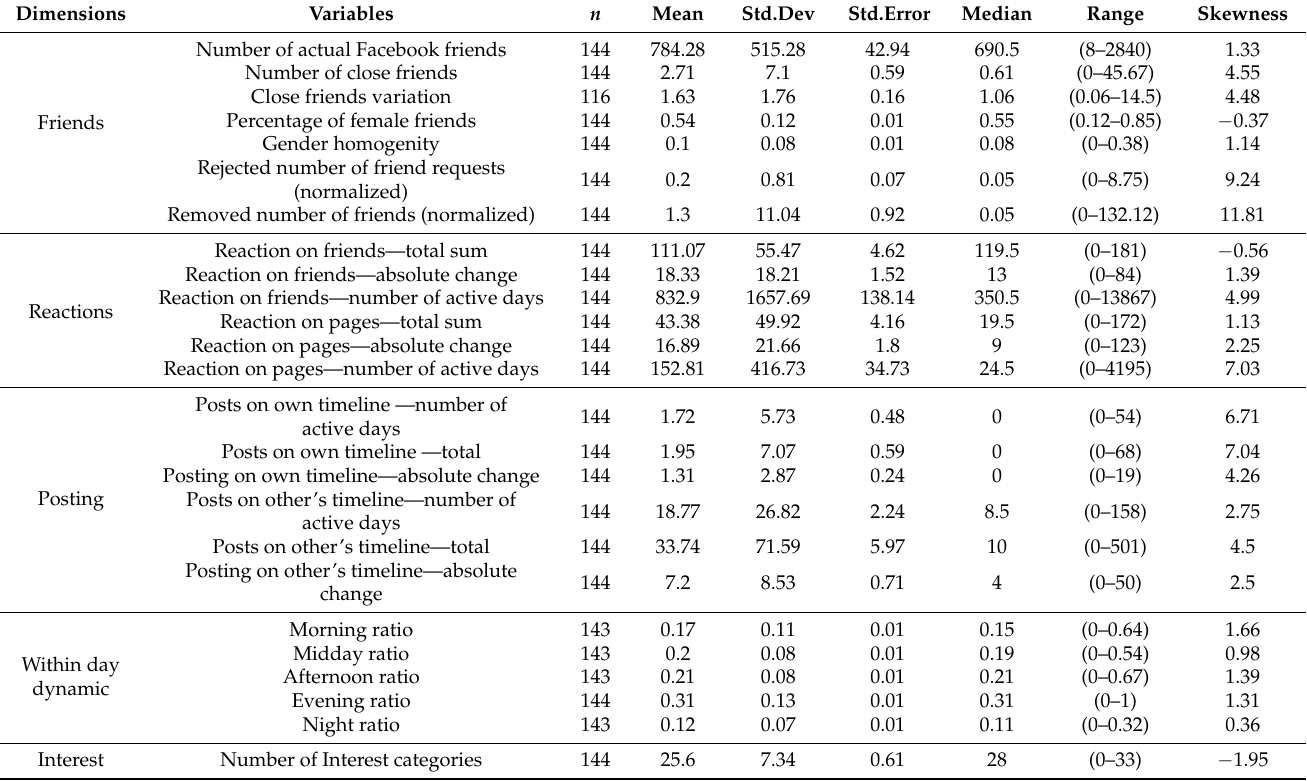
Table 2. Descriptive statistics of independent